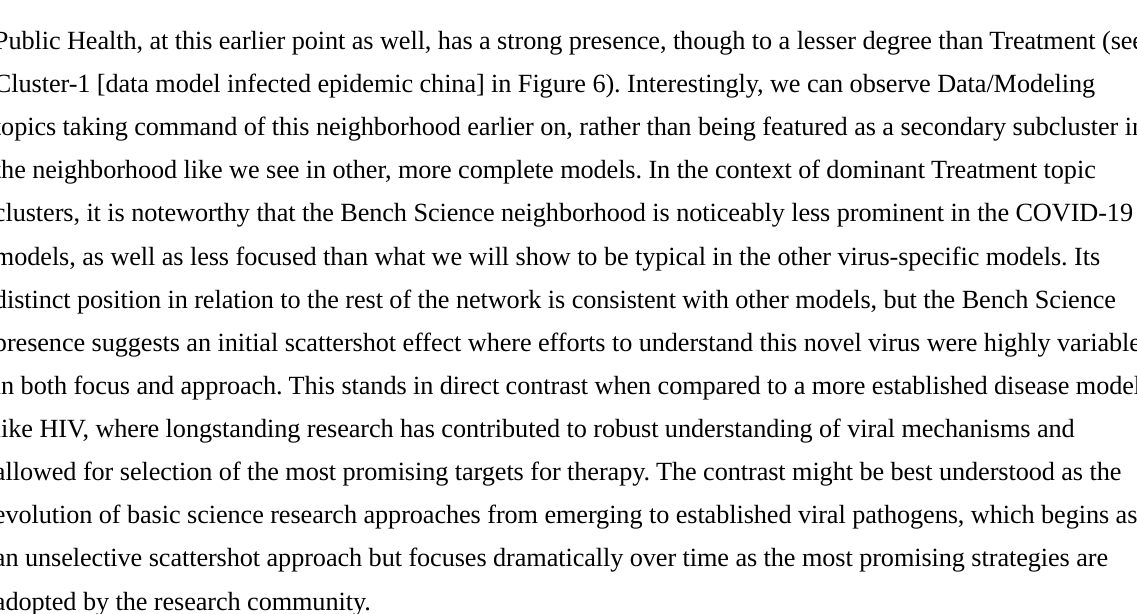
Figure 6. Network visualization of the COVID-19 Topic Model as of